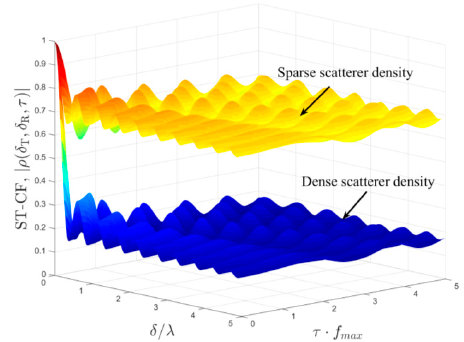
Figure 9. Analytical results of the spatial–temporal correlation function (ST-CF) ρ pq , p’q’ ( δ T , δ R , τ ) of the proposed model for low scatterer density and high scatterer density.